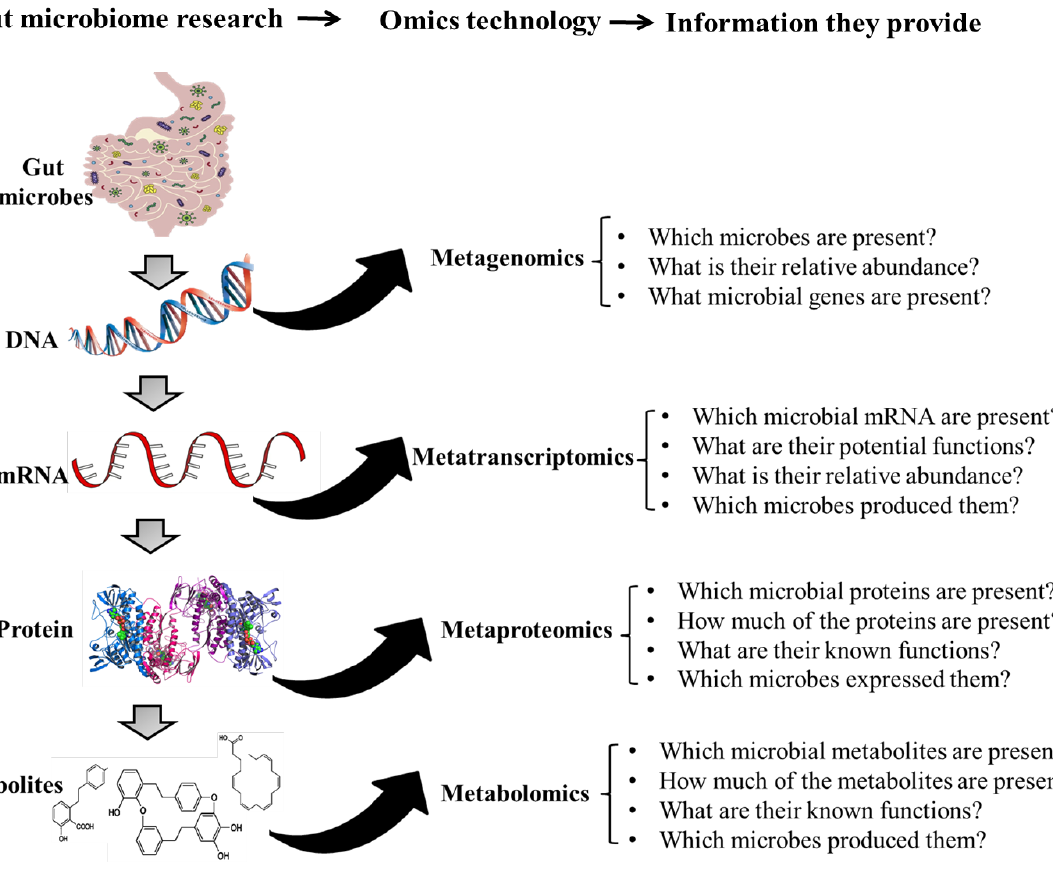
Figure 1. Omic technologies and the information they provide in gut-microbiome research.